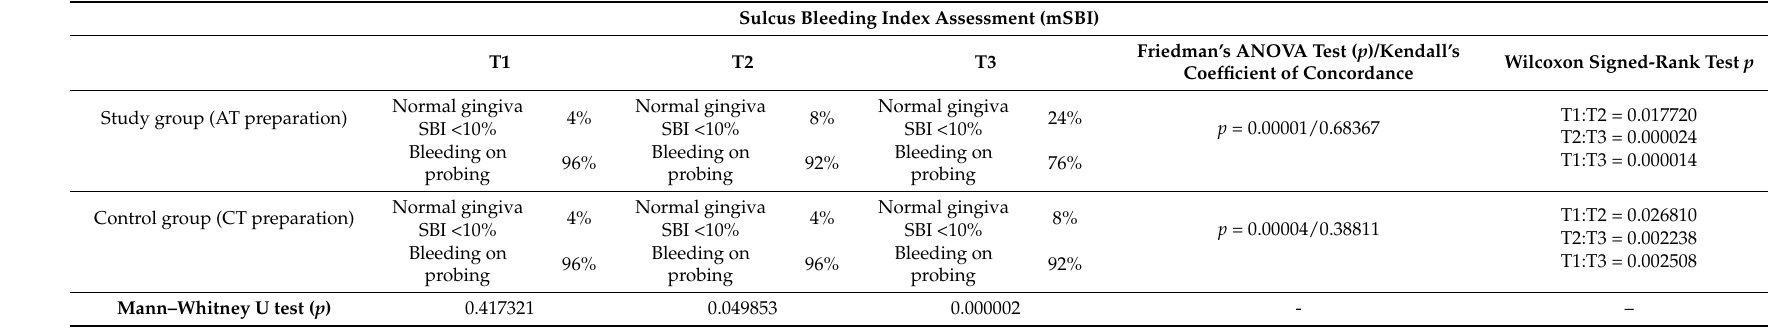
Table 2. Comparison of the mSBI values in study and control